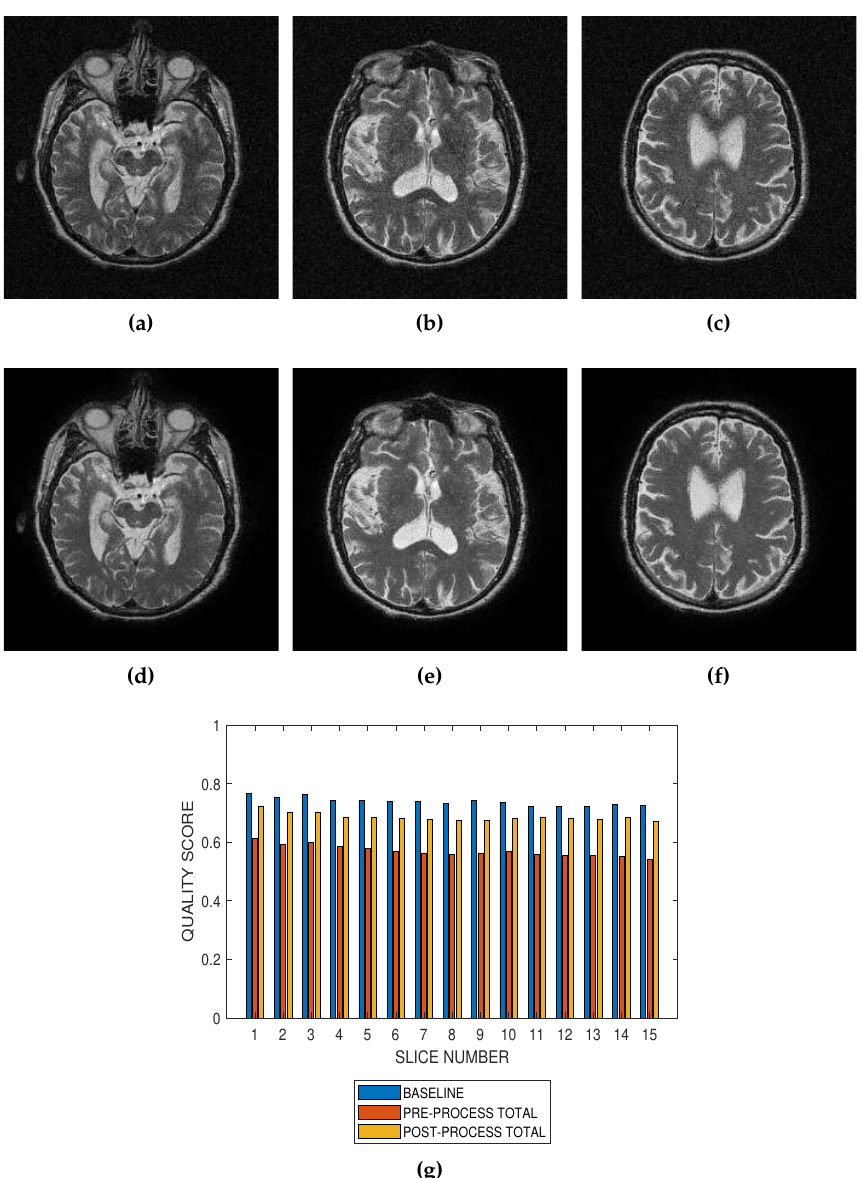
Figure 7. Application of the proposed method to the assessment of an image enhancement algorithm. ( a – c ) are slices numbers 20, 27 and 34, respectively in a T2 MRI volume degraded with 4 percent Rician noise. ( d – f ) are the slices displayed in ( a – c ) but their quality have been enhanced using a bilateral filter. ( g ) The baseline quality score of the original image, the predicted total quality indices of 12 successive T2 MRI slices in a volume data before and after enhancement with a bilateral